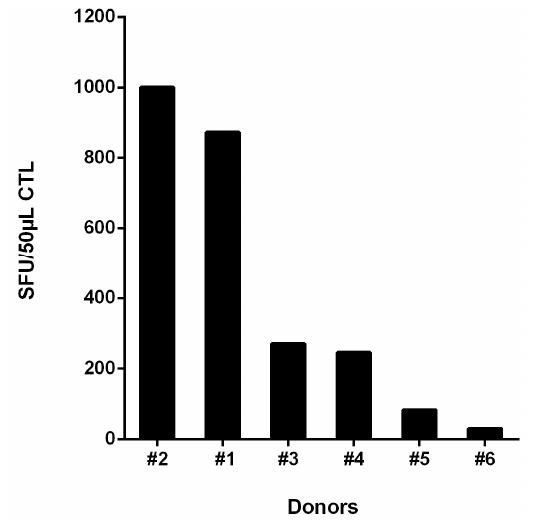
Figure 5. Recognition of peptide Rev-RI8 by HLA-B*52-positive HIV-1-infected subjects. PBMCs were incubated with peptide Rev-RI8 and IL2. After 10–14 days, 50 µL of outgrowing CTL were tested for peptide recognition at a final peptide concentration of 20 µg/mL.